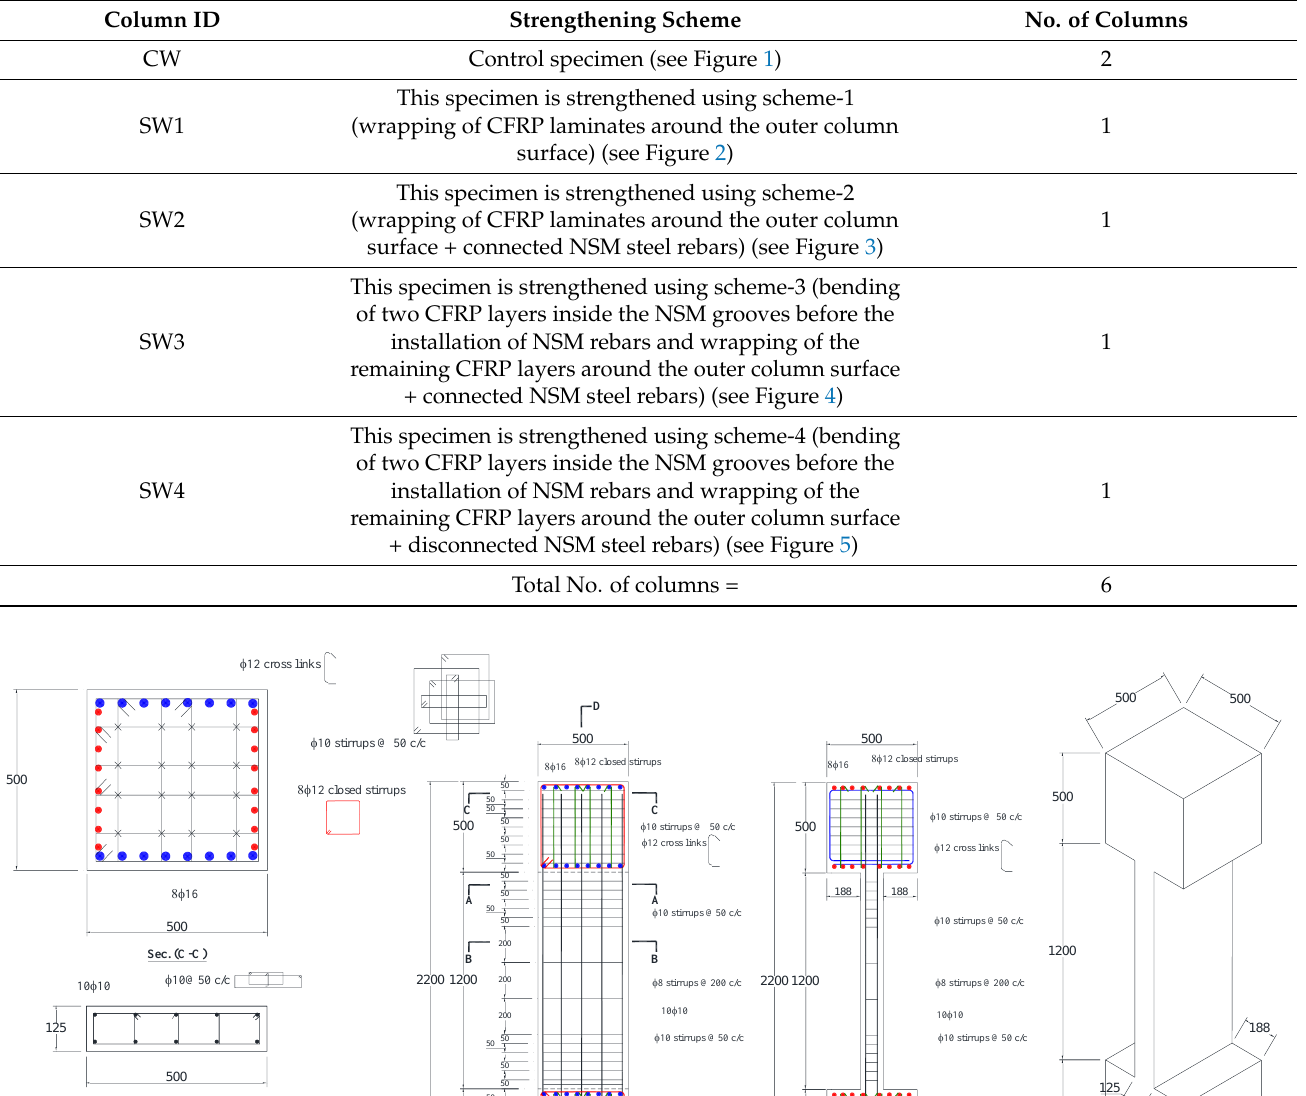
Table 1. Matrix of column testing.